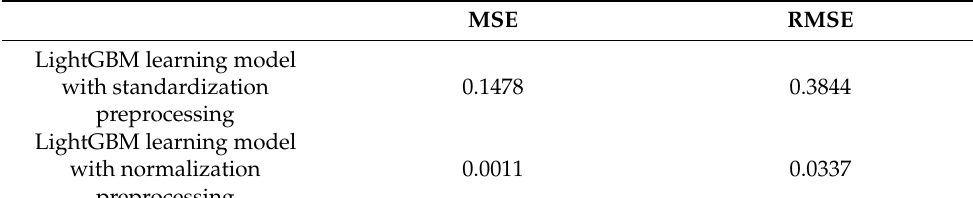
Table 5. Errors of the LightGBM model with different preprocessing methods.